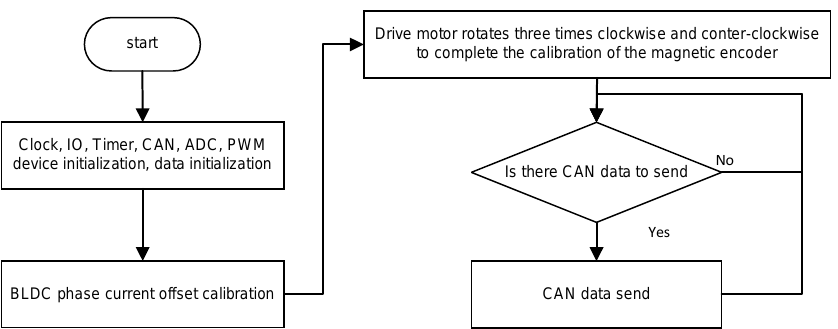
Figure 11. Main function program flow chart.